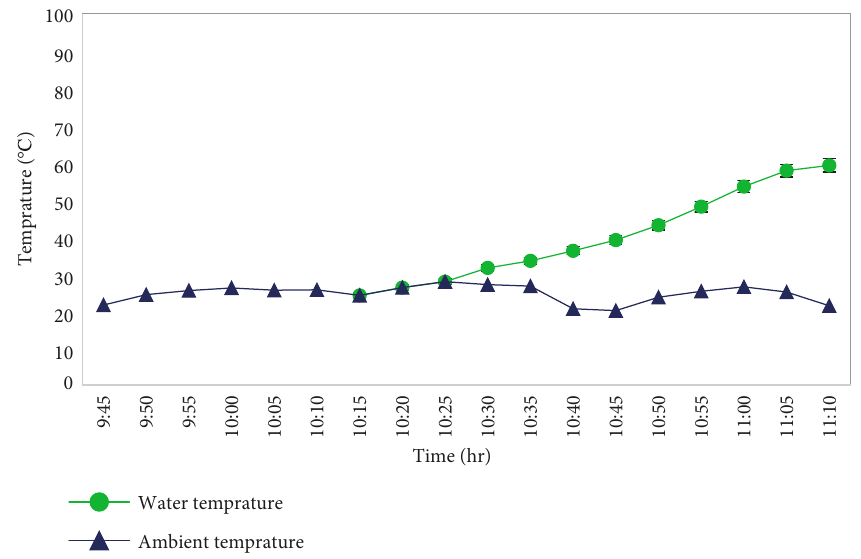
Figure 8: Condenser water temperature, ambient temperature, and solar radiation variation.